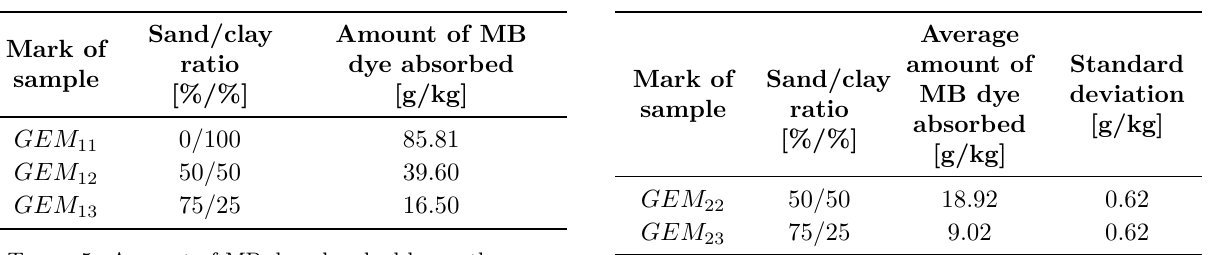
Table 7. Average values of amount of MB dye from methylene blue test without defined stirring